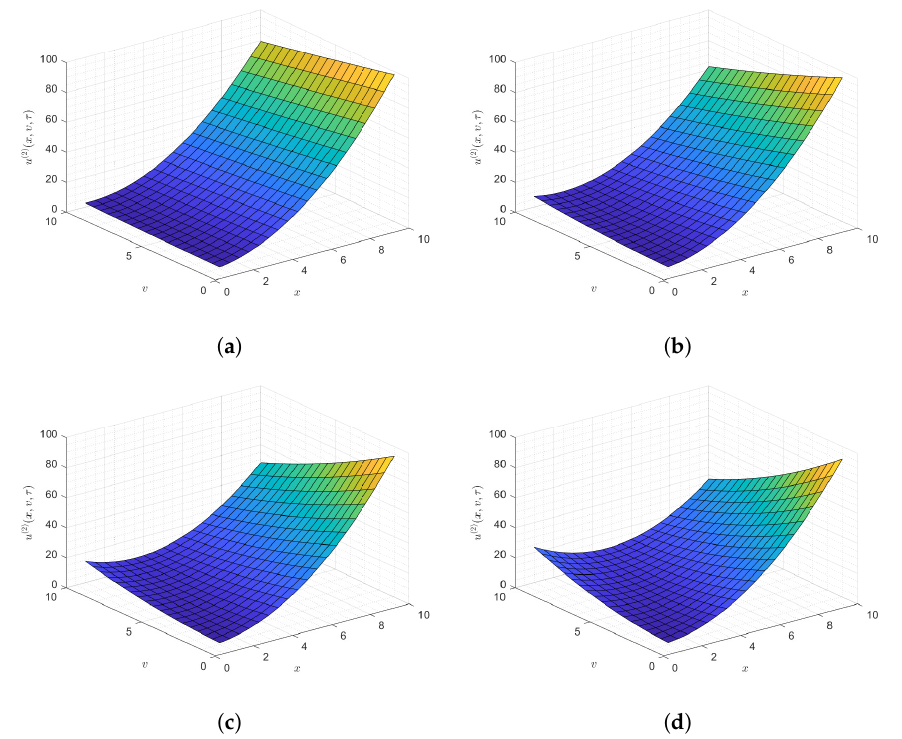
Figure 5. Surface plots of the second conditional moment u ( 2 ) ( x , v , τ ) by varying x , v ∈ [ 1,10 ] at different values of τ . ( a ) u ( 2 ) ( x , v ,0.25 ) . ( b ) u ( 2 ) ( x , v ,0.5 ) . ( c ) u ( 2 ) ( x , v ,0.75 ) . ( d ) u ( 2 ) ( x , v ,1 )